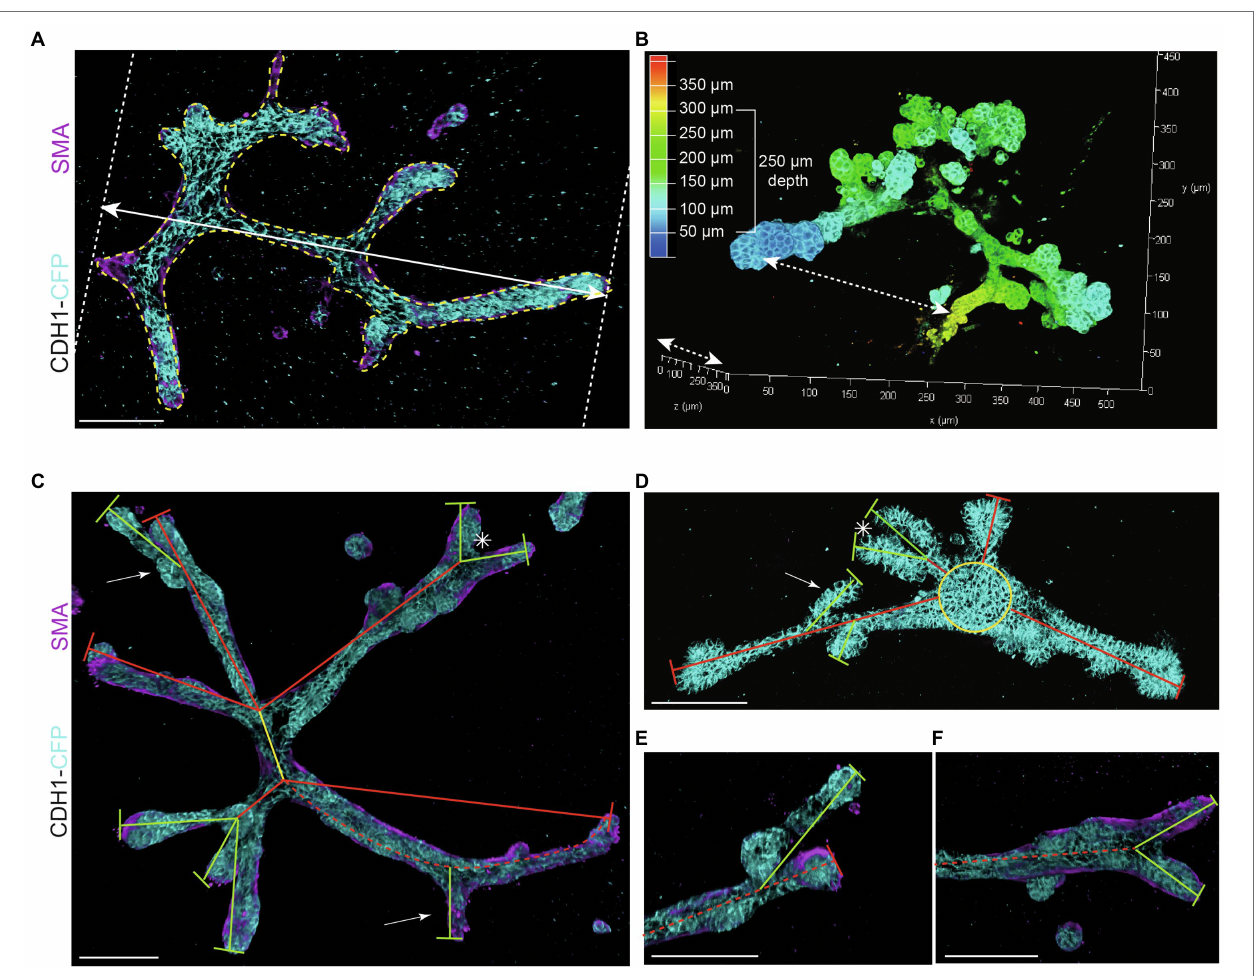
FIGURE 3 | Measurements to describe branched organoid morphology. (A) To determine organoid area, the borders of branched organoids were marked (yellow dotted line) using maximum intensity projections and the size of the yellow marked area was determined. Organoid length was measured in the direction of branch elongation (white arrow). (B) Organoid depth was measured using the depth coding function in LasX 3D visualization software (Leica Microsystems) or derived from the color scheme of the depth scale bar. (C) Representative 3D rendering of a branched organoid lacking a central core after elongation and branching. The primary branch was defined as the center of the organoid (yellow line), connected to secondary branches (red lines) and tertiary branches (green lines). Bifurcation point is indicated with asterisk; side branches/buds are indicated with white arrows. Branch length was calculated as the distance between two branch points or the distance between branch tip and previous branch point. (D) Representative 3D rendering of an organoid partially retaining a central core (yellow) after elongation. Primary branches are indicated with red lines, and secondary branches are indicated with green lines. Asterisks refer to bifurcation points; white arrows indicate side branches. (E,F) Zoom images of a side branch (E) and a bifurcation point (F) of the organoid depicted in (C) . Cdh1-CFP is shown in cyan; smooth muscle actin labeling is shown in magenta. Scale bars represent 100 μ